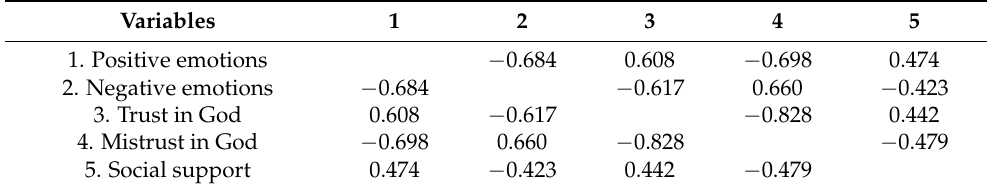
Table 2. Correlations of PANAS positive and negative emotions.